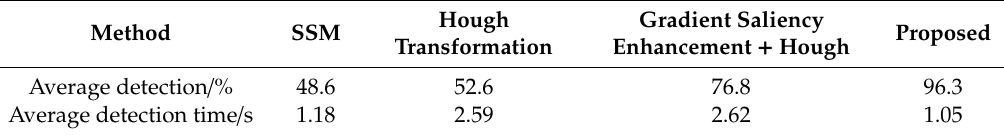
Table 1. Comparison of the detection performance of di ff erent